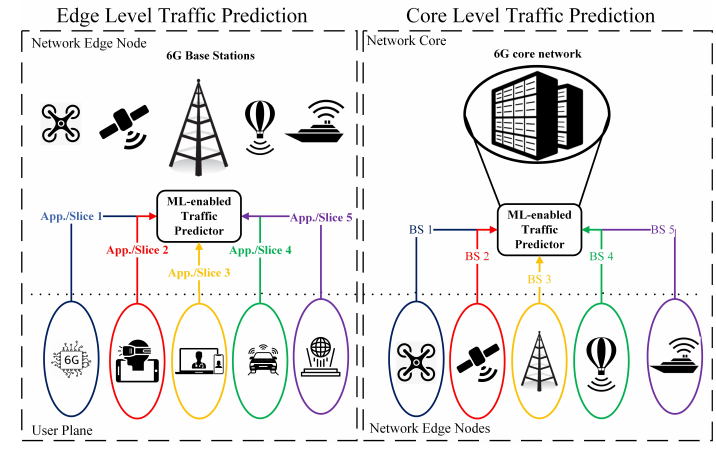
Figure 7. Potential ML-enabled 6G traffic prediction architectures.